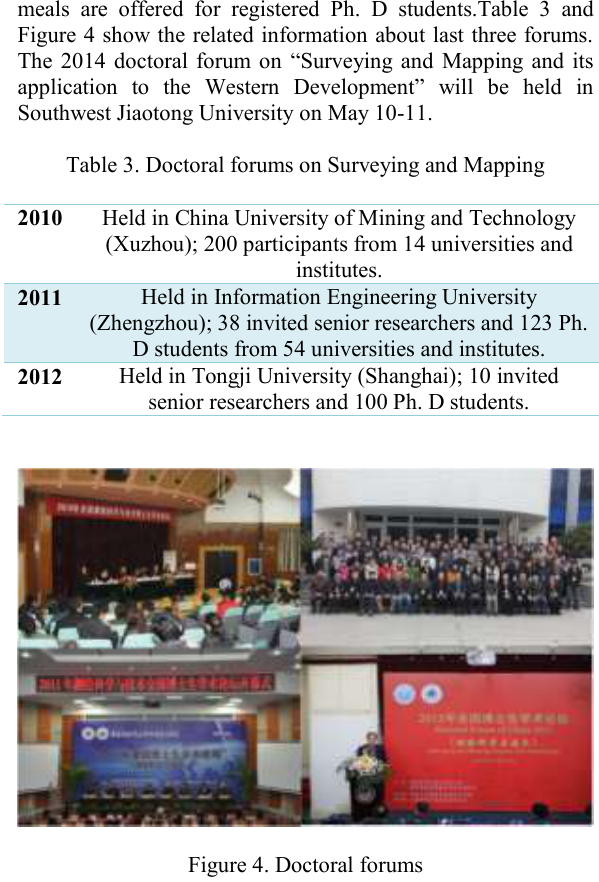
Figure 5. Summer school